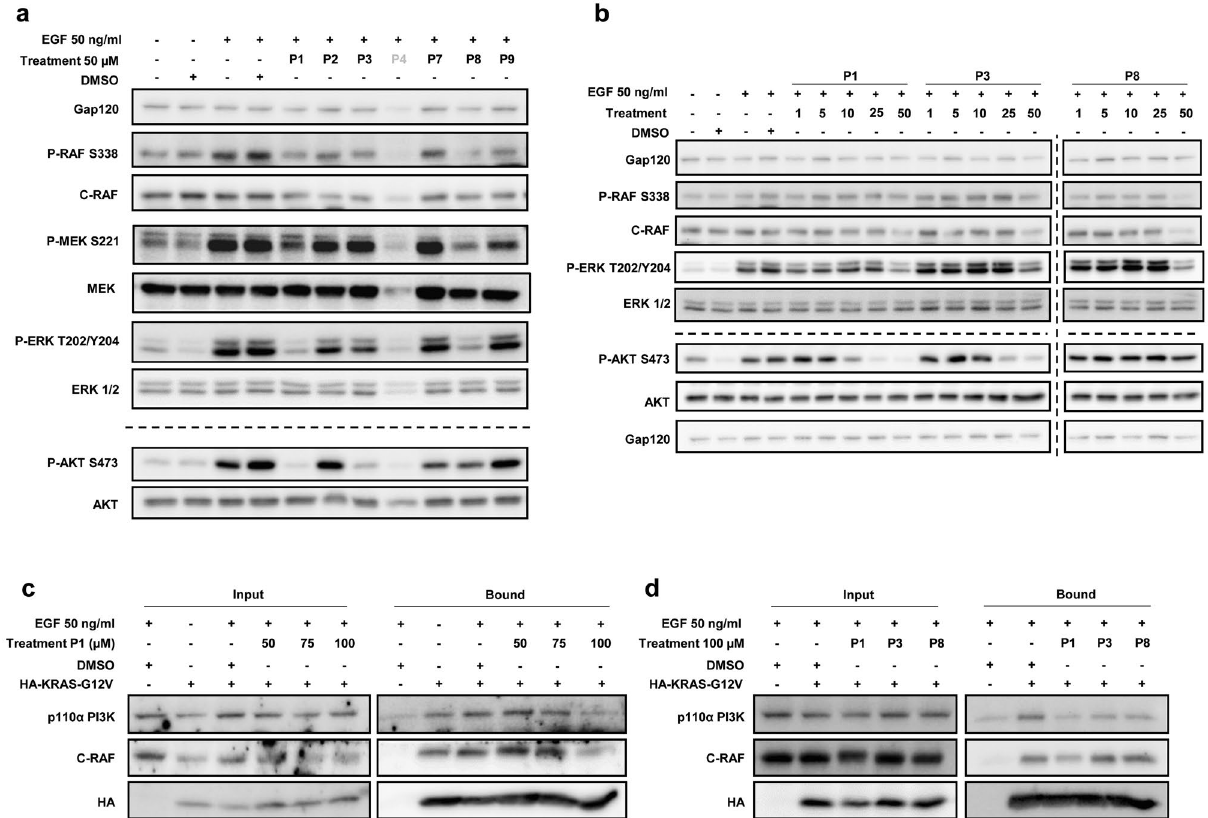
Figure 3. P1 diminishes endogenous downstream RAS signalling and disrupts KRAS interaction with the effectors c-RAF and PI3K. ( a ) hTERT-RPE starved cells were incubated with 50 µM of the indicated peptidomimetics for 2 h and the levels of activation of the RAF/MEK/ERK and PI3K/AKT pathways after EGF stimulation for 10 min were studied by Western blot. Specific antibodies against the active phosphorylated and total proteins were used. GAP120 was utilized as a loading control. ( b ) The same analyses were performed as in ( a ), but incubating the cells with the indicated peptidomimetics in a range from 1, 5, 10, 25 and 50 µM. ( c ) Co-immunoprecipitation of HA-KRASG12V with C-RAF or with PI3K was analysed in starved HeLa cells expressing HA-KRASG12V after being incubated with P1 (in a range from 50, 75 and 100 µM) for 2 h, and EGF-stimulated for 10 min. IP was performed with anti-HA antibodies and Western blot of the bound and input fractions with anti-p110αPI3K and anti-C-RAF. ( d ) The same analyses as in ( c ) were done, but incubating the cells with 100 µM of the indicated peptidomimetics. All experiments were repeated at least three